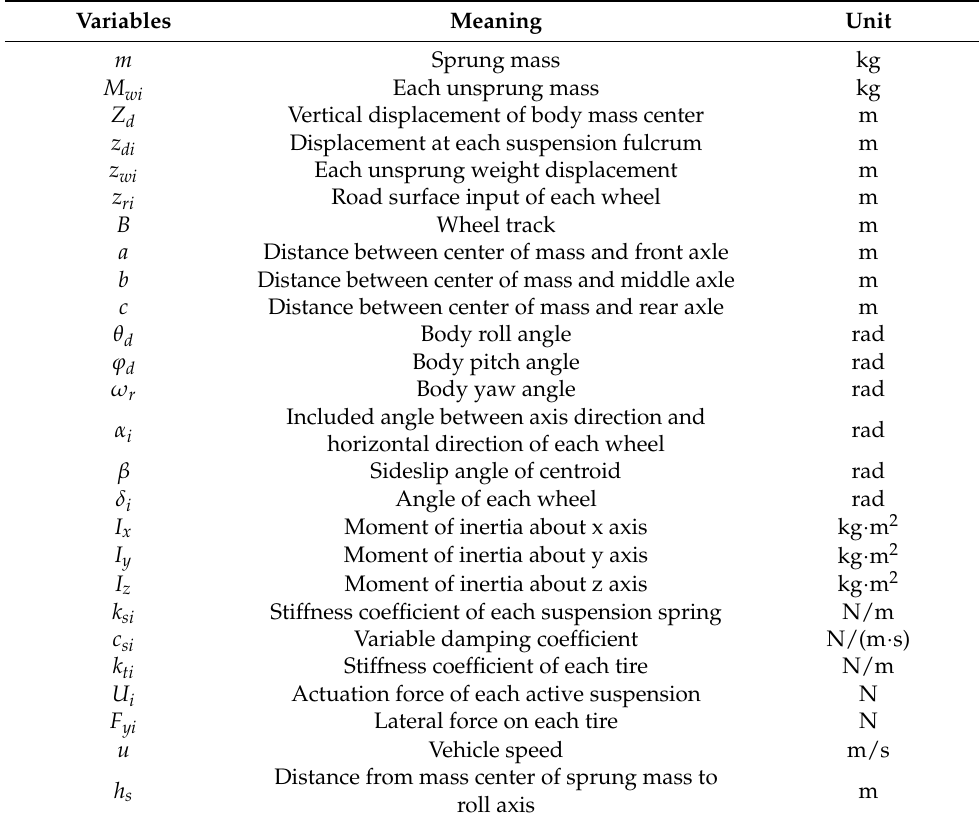
Table 1. Model variables ( i = 1, 2, . . . ,